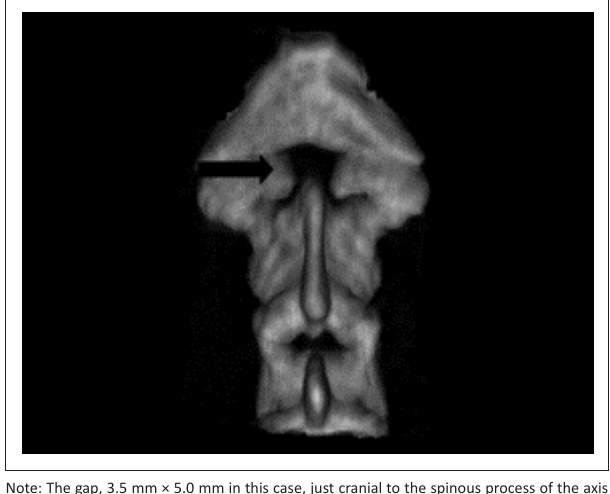
Note: The gap, 3.5 mm × 5.0 mm in this case, just cranial to the spinous process of the axis through which the hypodermic needle is passed (arrow). The potential interarcuate space is partially covered by the cranial projection of the spinous process (axis). FIGURE 2: Volume rendered computed tomography image of the cranial cervical region of a young Nile crocodile. Results Anatomy of the post-occipital cervical region and spinal venous